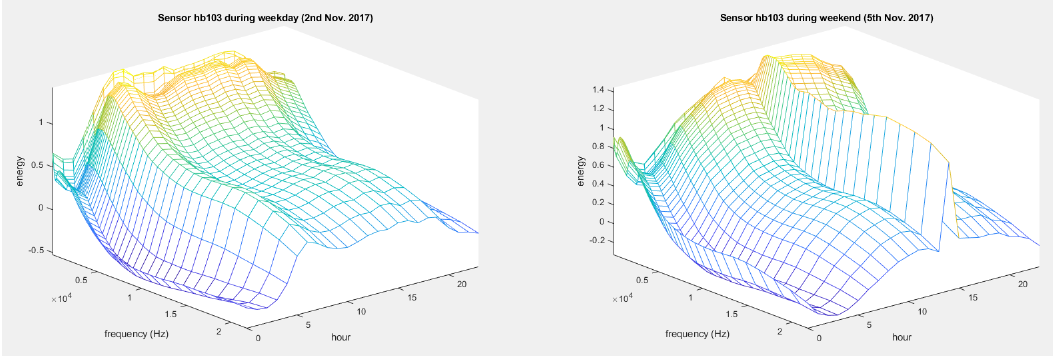
Figure 5. Spectrum-time profiles of the sensor hb103 (2 and 5 November